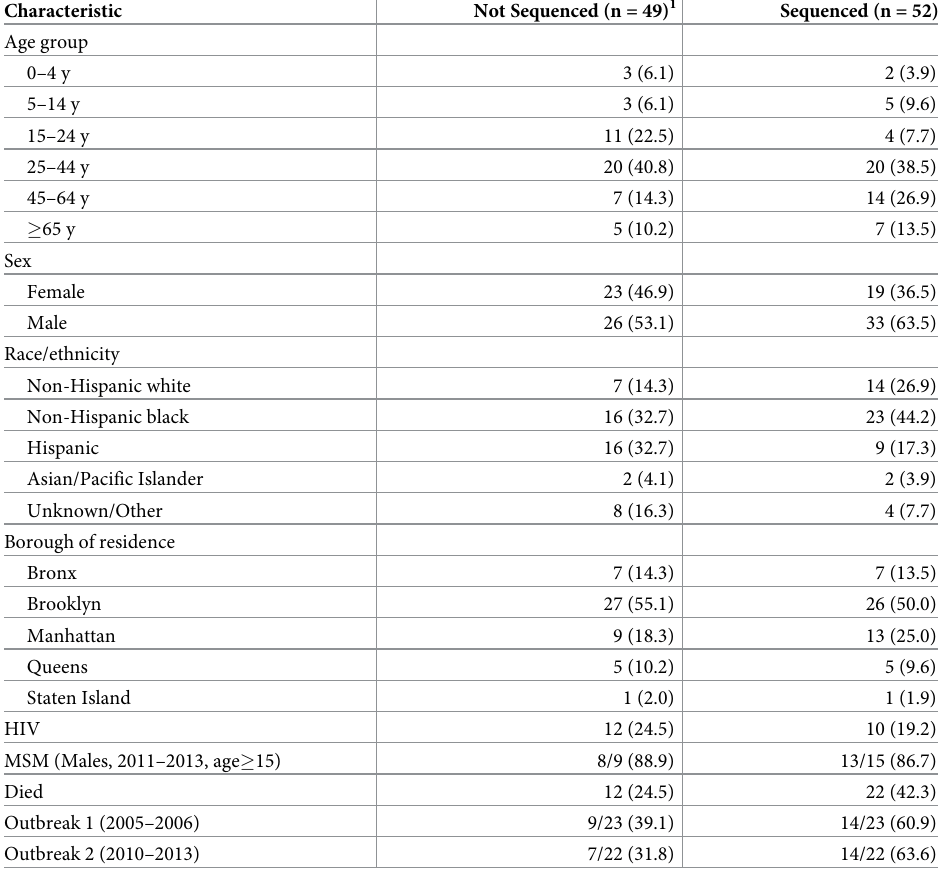
Table 1. Characteristics of sequenced invasive MenC isolates compared to those that were unavailable (confirmed and probable IMD cases), New York City,